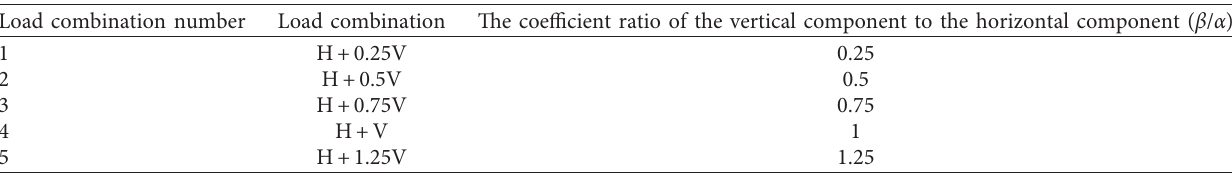
Table 9: Load combinations, including a horizontal component having coefficient 1 and a vertical component with a variable coefficient.